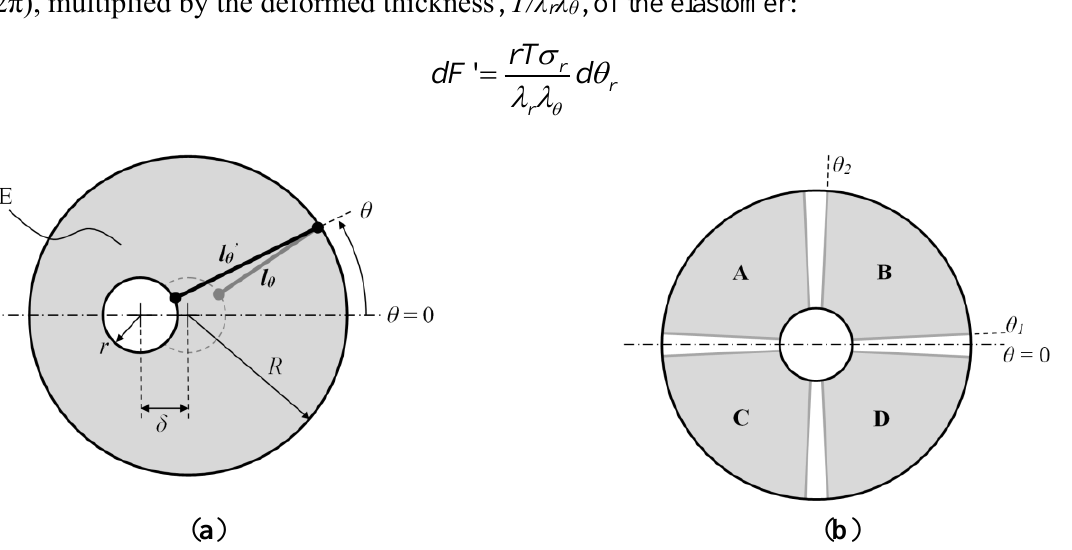
Figure 4. ( a ) Representation of change in elastomer length, from l θ to l θ ’ , along the first principal axis (radial) due to output displacement, δ . The elastomer is contained within a rigid boundary with radius R and contains a rigid inclusion with radius r . ( b ) Electrodes B and D are activated to induce δ and the axis of actuation, and line of symmetry, is the line from θ = 0 to θ =